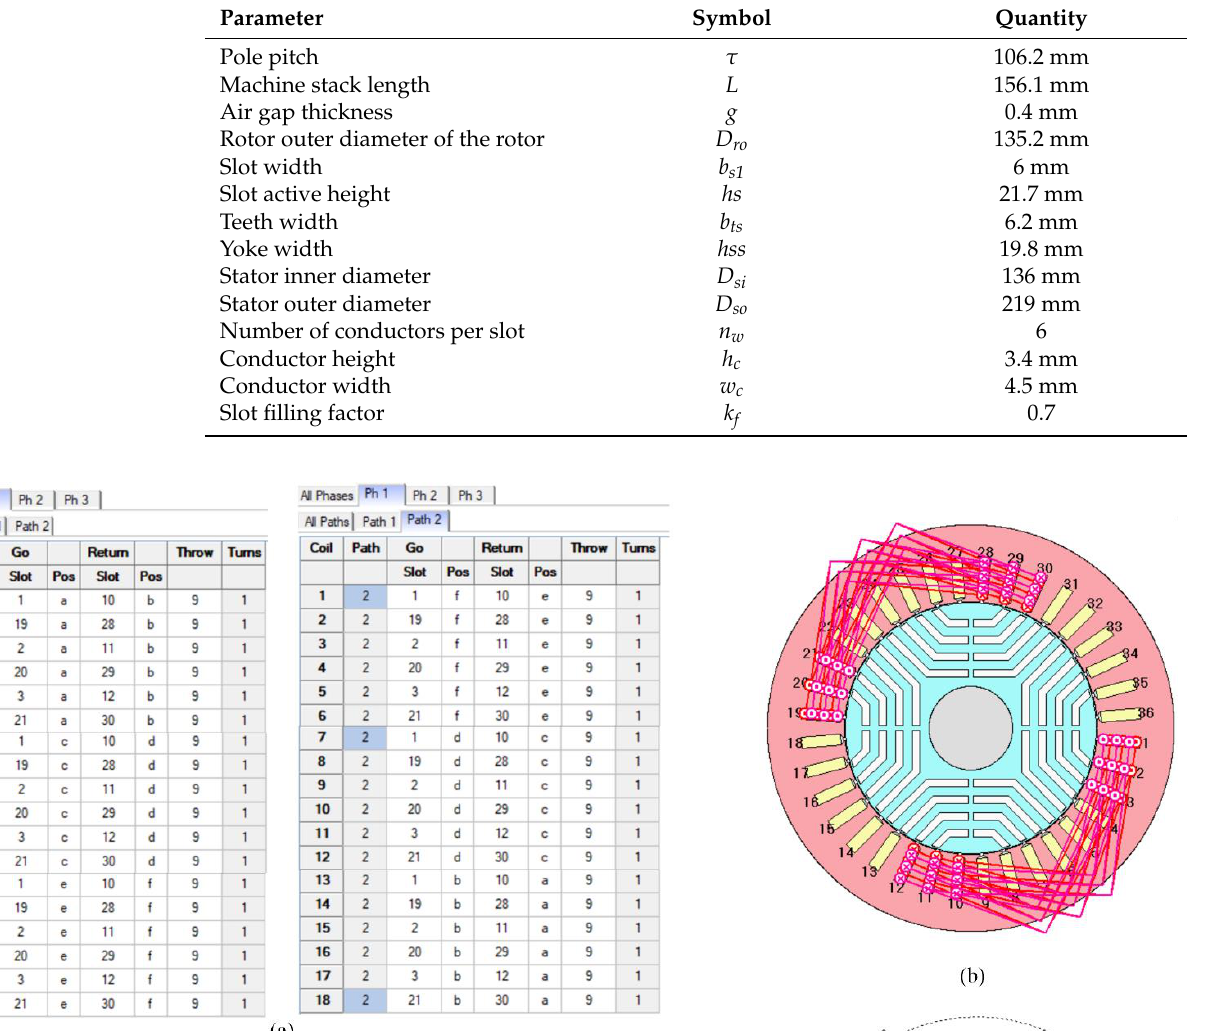
Table 1. SynRM parameters.